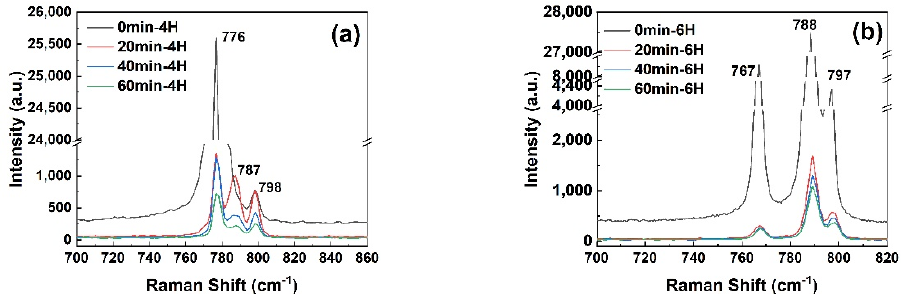
Figure 12. Raman spectra of micropipes etched for different amounts of time in 4H-SiC ( a ) and 6H-SiC ( b ).